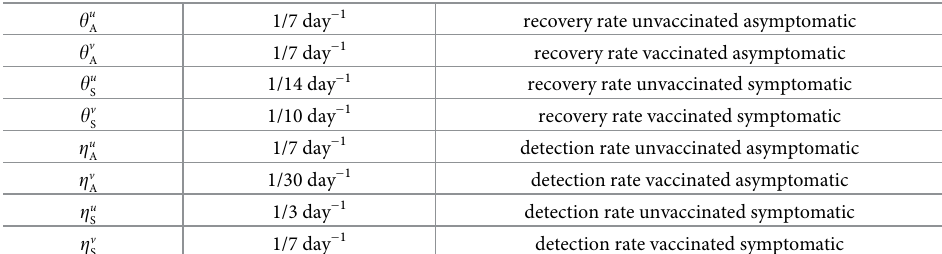
Table 2. Fitting time independent rates in Eq (1).